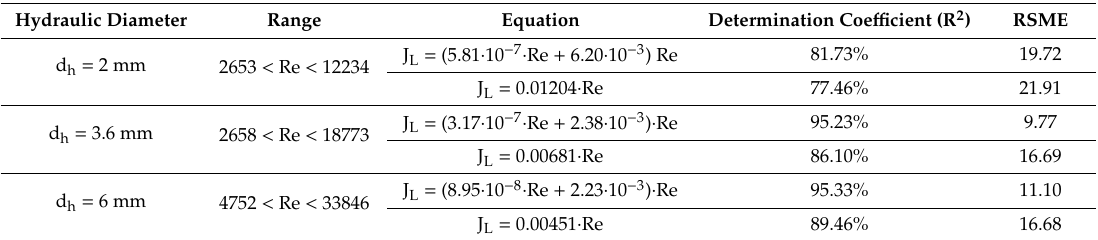
Table 5. Correlations between the limiting flux and the Reynolds number for skim milk